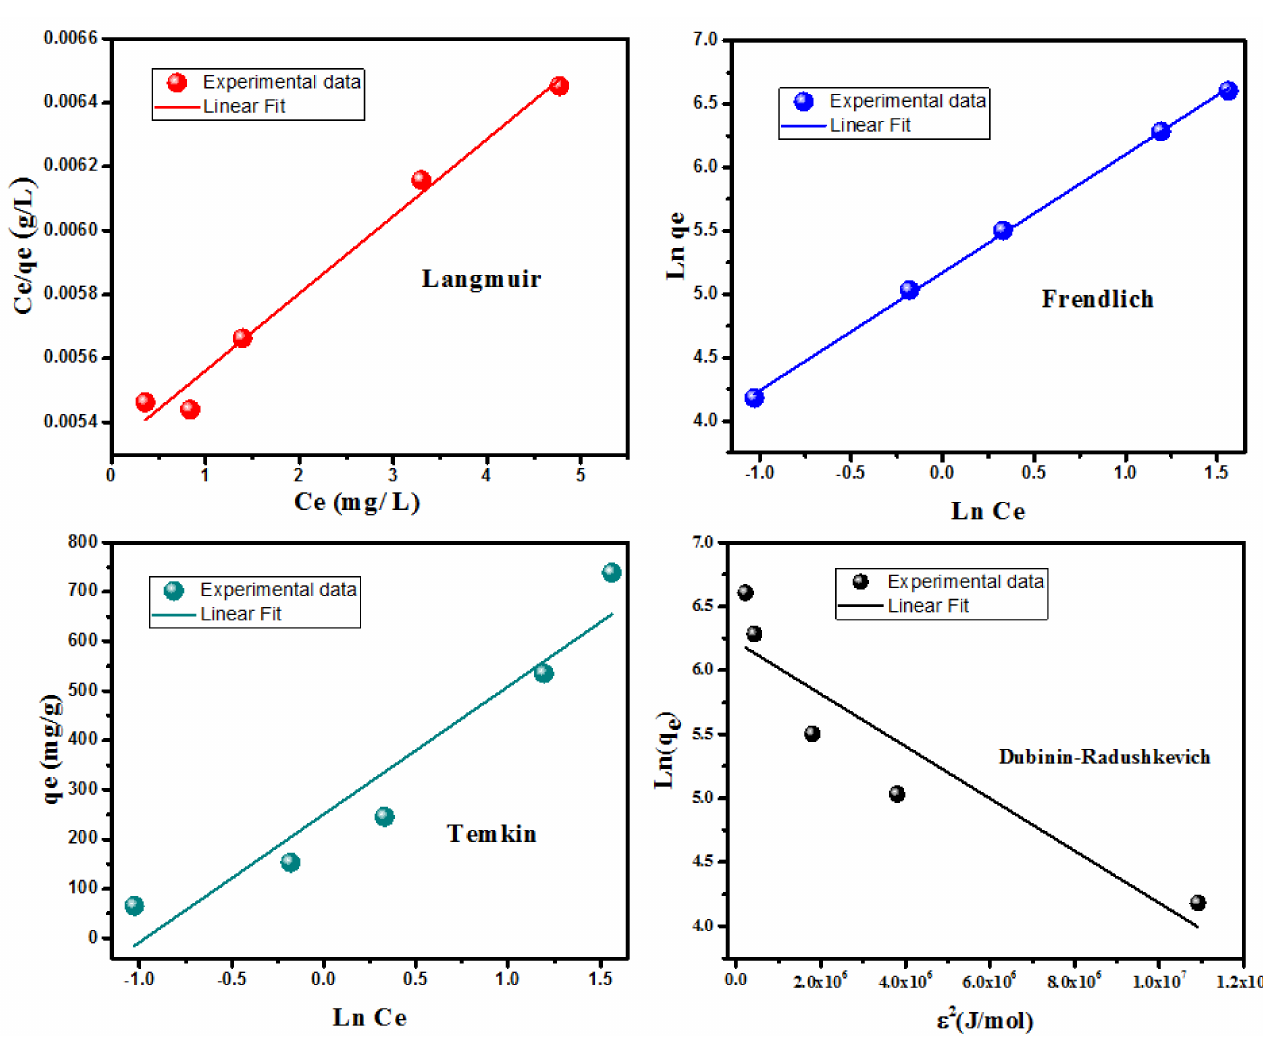
Figure 6. Adsorption of BF equilibrium